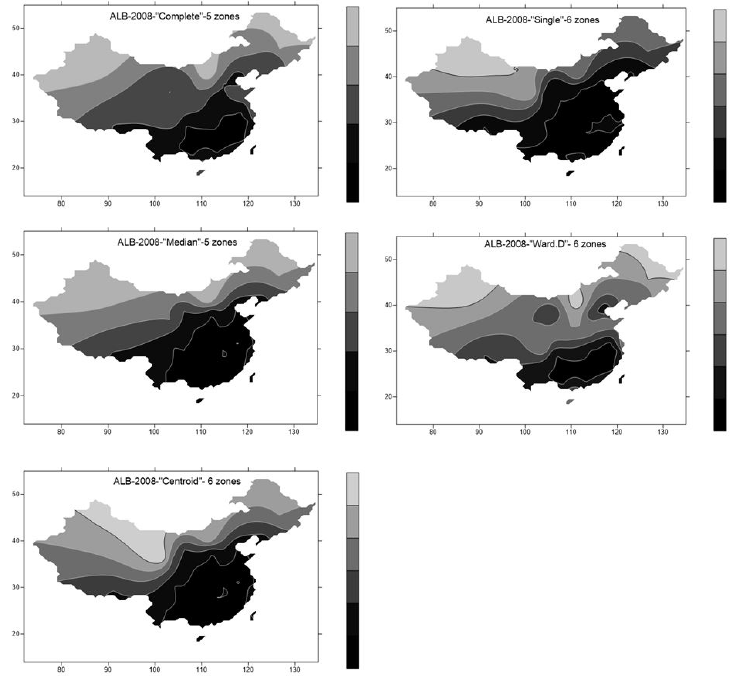
Figure 4. Classification of surface albedo (ALB) using 5 different methods (2008).